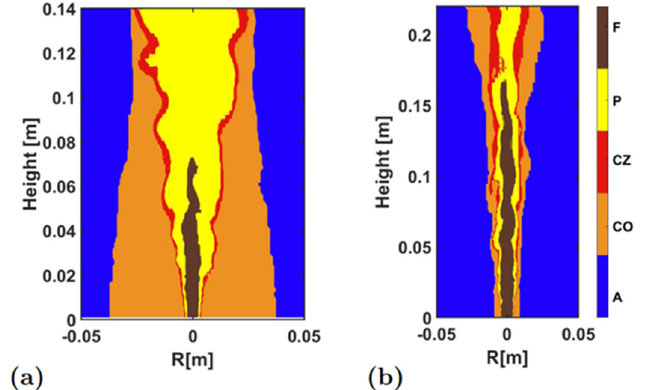
Figure 8. CRI results of BPNN with five-dimensional input: ( a ) HM1; ( b ) Sandia Flame D.